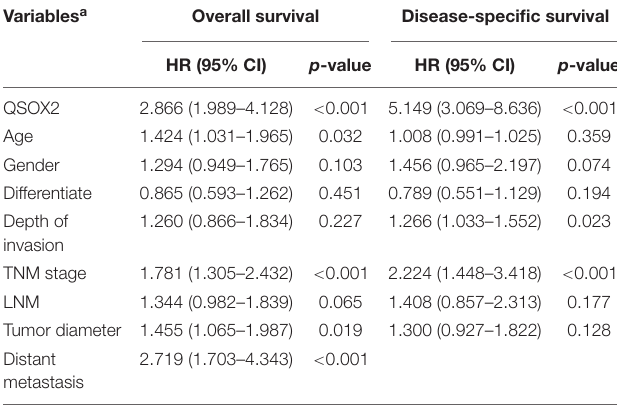
TABLE 7 | Univariate Cox regression analysis on OS and disease-free survival (DFS) in CRC based on clinical specimen cohort. Variables a Overall survival Disease-specific survival